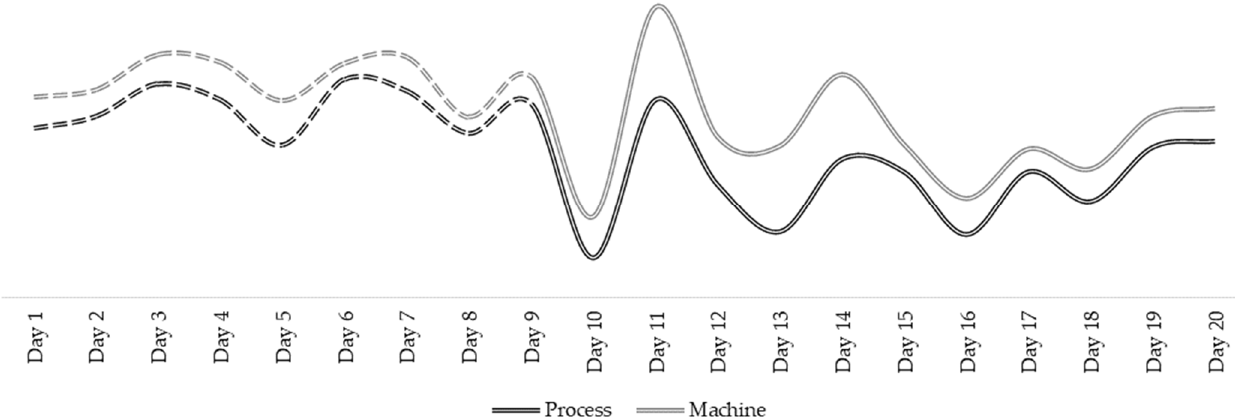
Figure 5. Quality rate trend for the semi-automatic packaging machine.